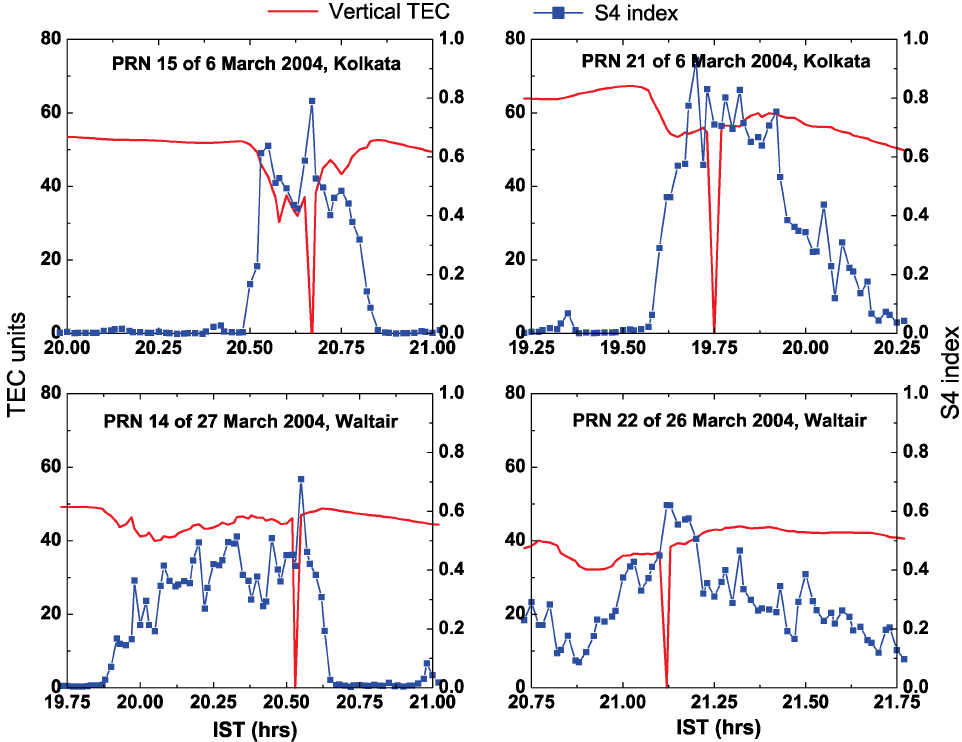
Fig. 8. Typical examples of scintillation activity showing the values of the S4 index exceeding 0.45, causing a loss of lock in the GPS